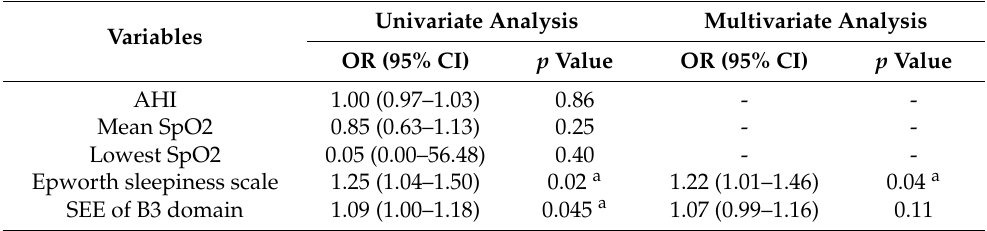
Table 4. Univariate and multivariate logistic regression models used to predict tinnitus.